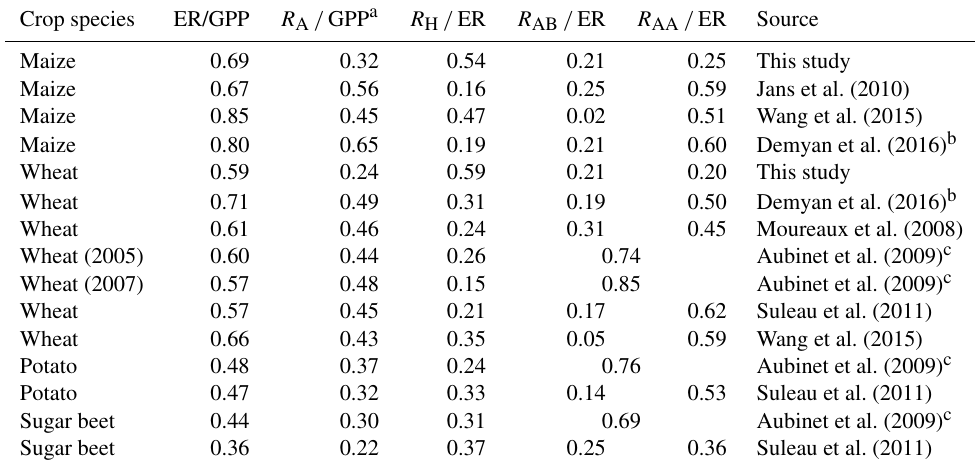
Table 2. Various ratios associated with carbon fluxes in croplands. Crop species Maize